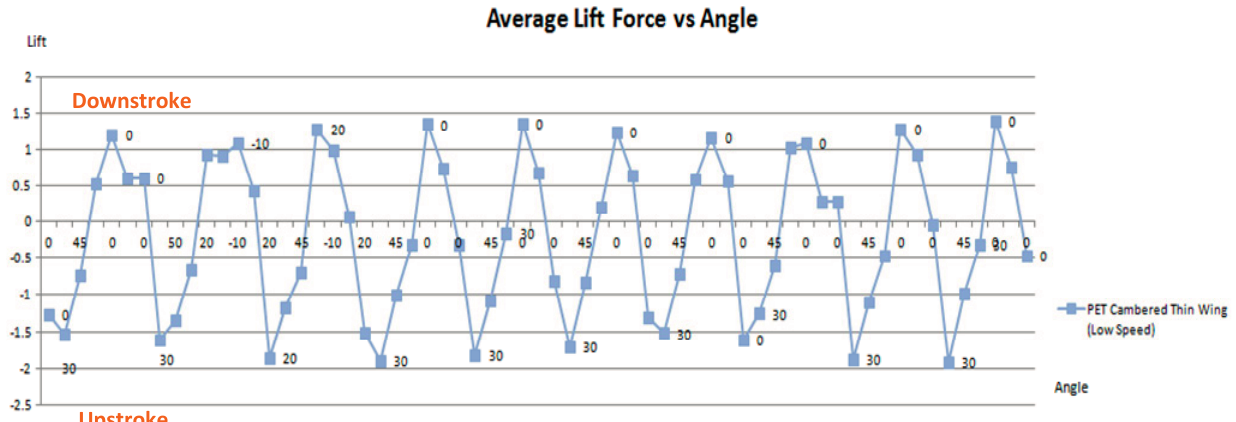
Figure 36. Average lift Force vs . angle (PET cambered thin